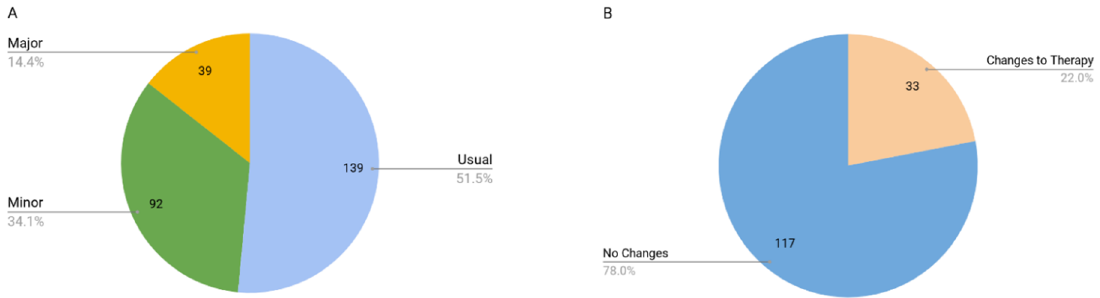
Figure 4. ( A ) Visualization of major, minor, and usual drug considerations discovered, N = 150; ( B ) Visualization of medication changes in response to the study, N = 150.